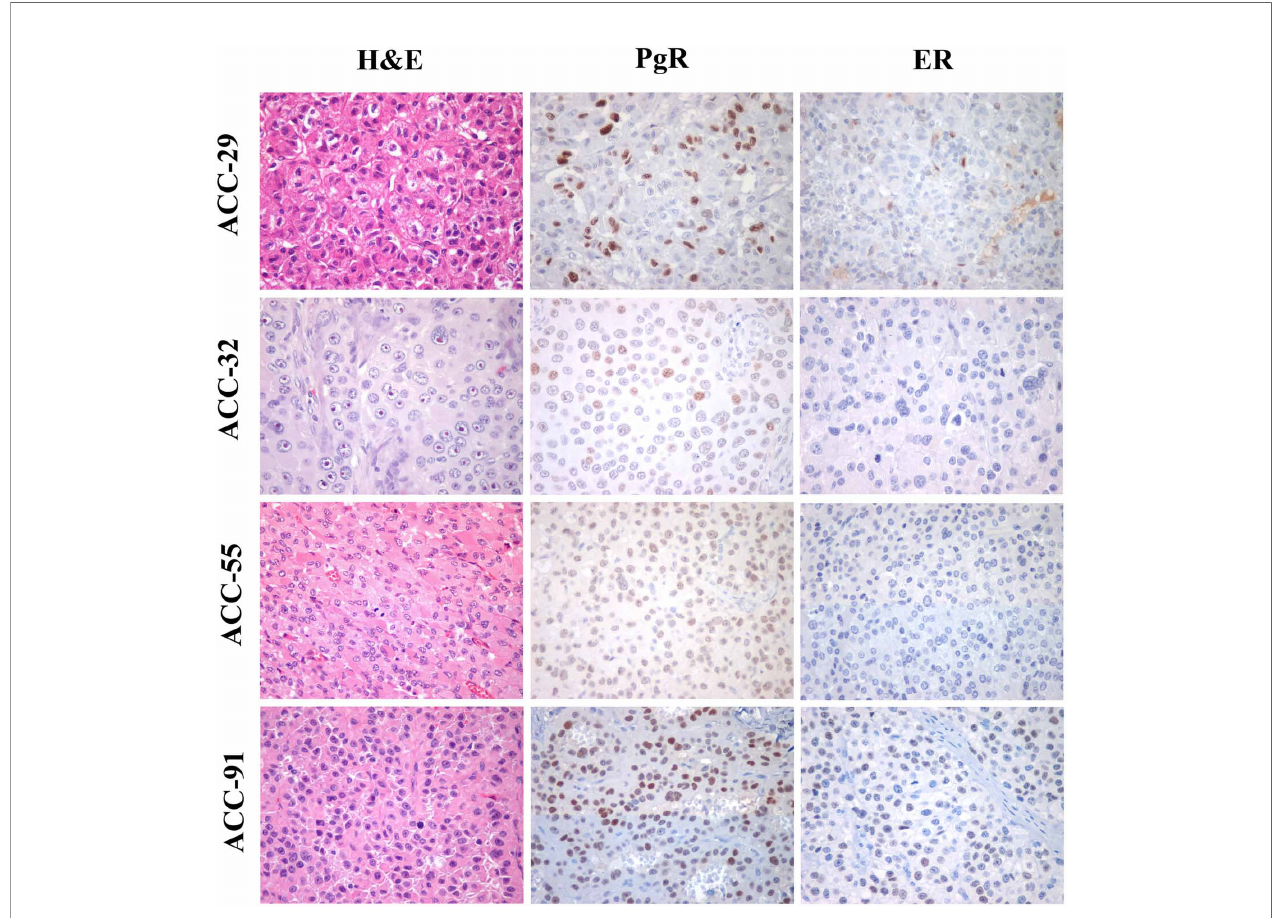
FIGURE 8 | Immunohistochemistry for PgR and ER expression in ACC samples. Left panels show representative H&E-stained section from ACC tumor samples, middle panels PgR and right panels ER immunostainings. All images are from ×40 original magni fi